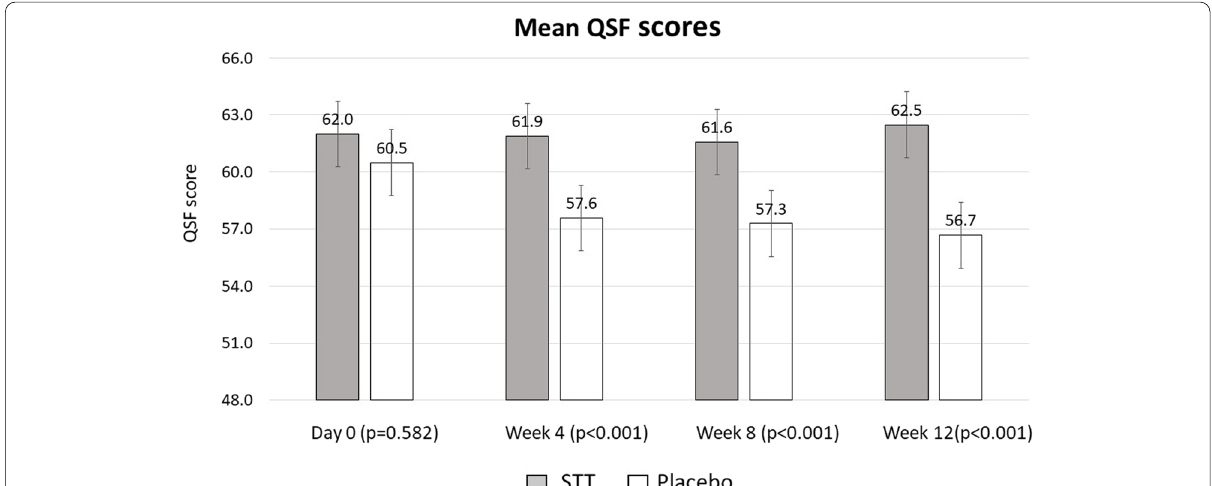
Fig. 4 The mean Quality of Sexual Function (QSF) scores between the STT and placebo groups during the study period: The mean QSF scores showed a significant increase in the STT group (the gray column, N fourth visit, week 12), whereas the scores of the placebo group (the white column, N